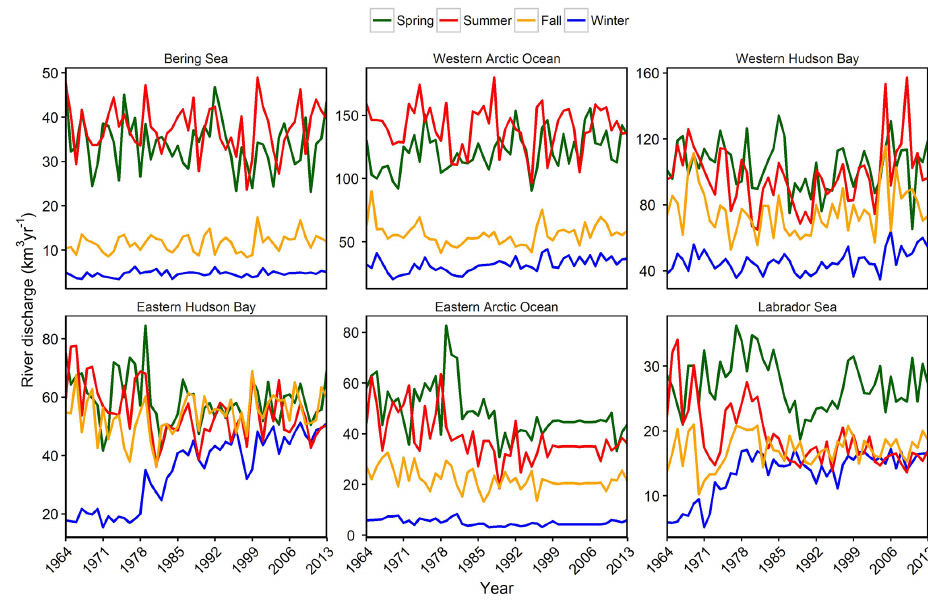
Figure 4. Time series of total seasonal discharge for six major drainage basins of northern Canada, 1964–2013. Table 3. Paired comparisons of decadal statistics for the mean, standard deviation (SD) and coefficient of variation (CV) of annual river discharge for eight regulated and seven matching unregulated